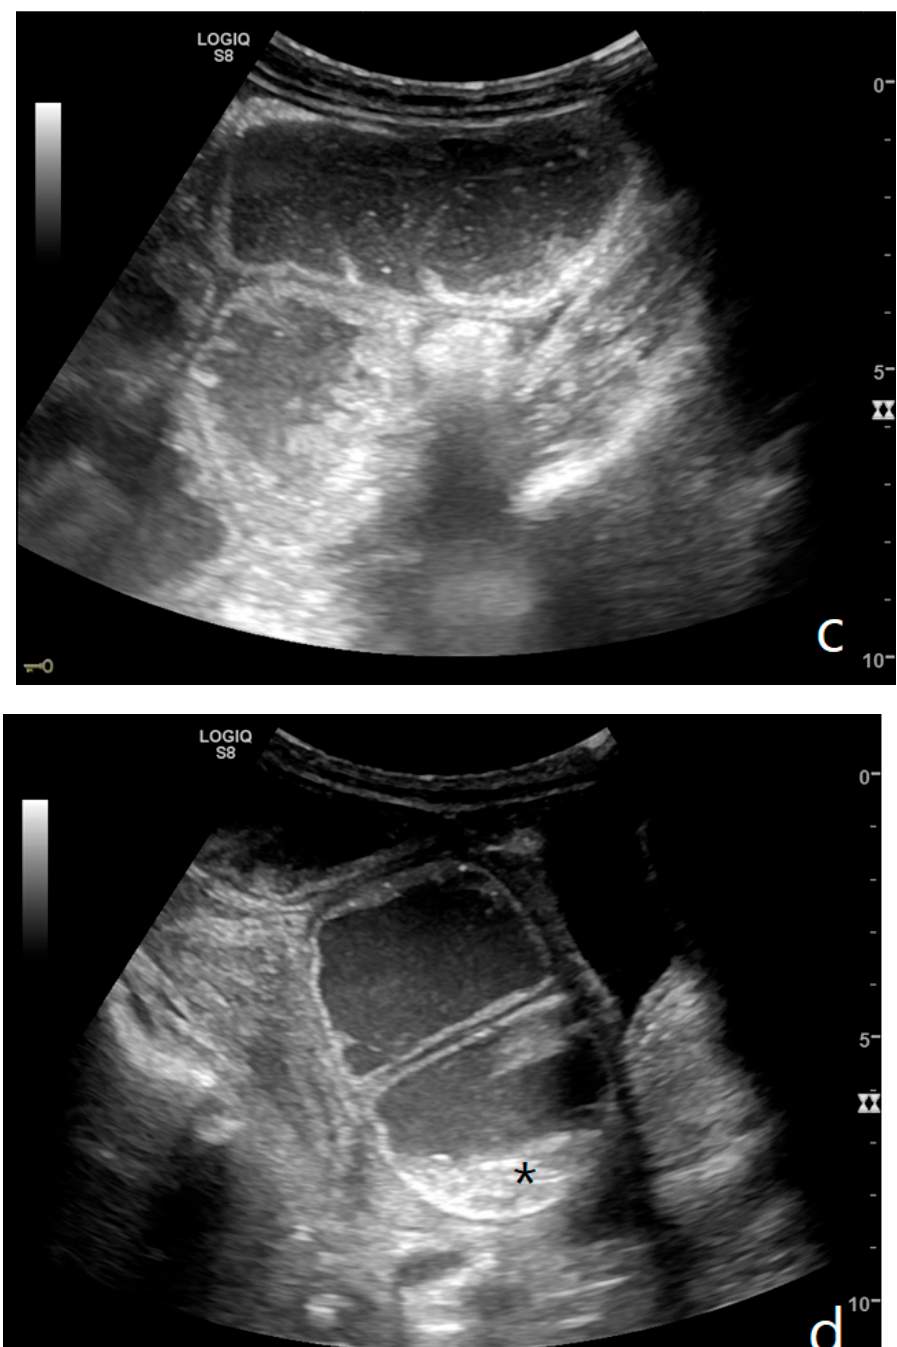
Figure 4. A complicated SBO in a 69 ‐ year ‐ old male with gastric cancer and peritoneal carcinosis. Ultrasound images show long ( a ) and axial ( b ) evaluations of a fluid ‐ filled, dilated small bowel loop with hyperechogenic floating material (shown with an asterisk) ( b , d ). Bowel peristalsis was absent. Mild parietal and valvulae conniventes thickening are present ( c , d ). Downstream loops present normal caliber (bowel jump diameter). Free fluid is interposed between bowel loops (black arrow) ( a ).